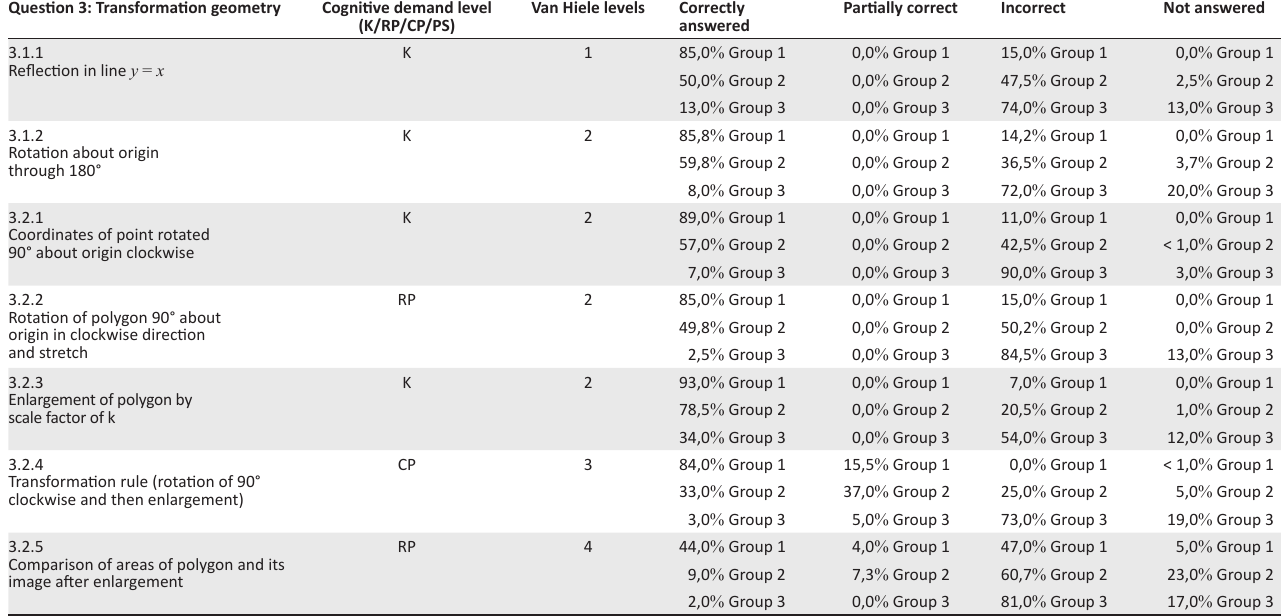
TABLE 1: Students’ attempts to answer Question